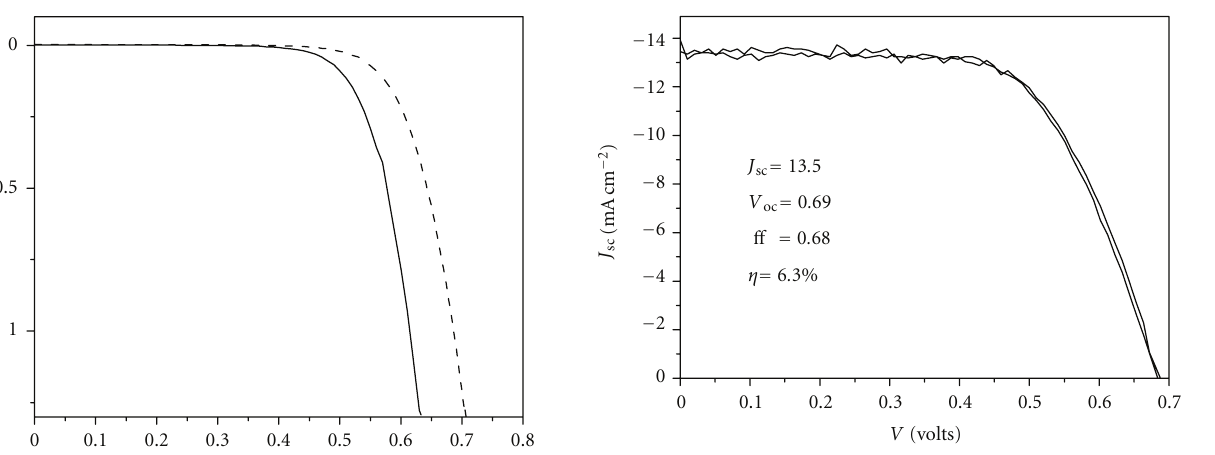
Figure 5: Current-voltage curve for a DSC with a photoanode having an acid TiO 2 film deposited over an alkaline TiO 2 layer (AM 1.5 illumination; 100 mWcm − 2